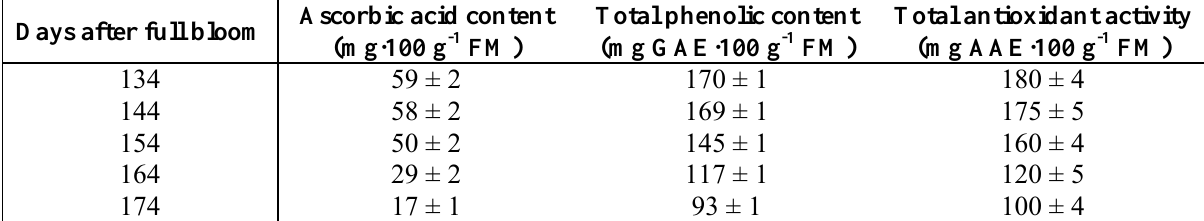
Table 4. The total phenolic content, total antioxidant activity and the ascorbic acid content of extracts of